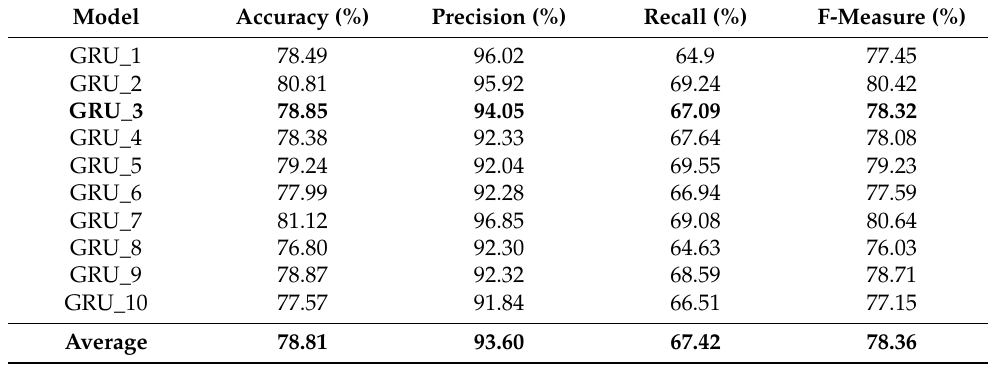
Table 6. Experimental results of the GRU model using the NSL-KDD test dataset as a benchmark.